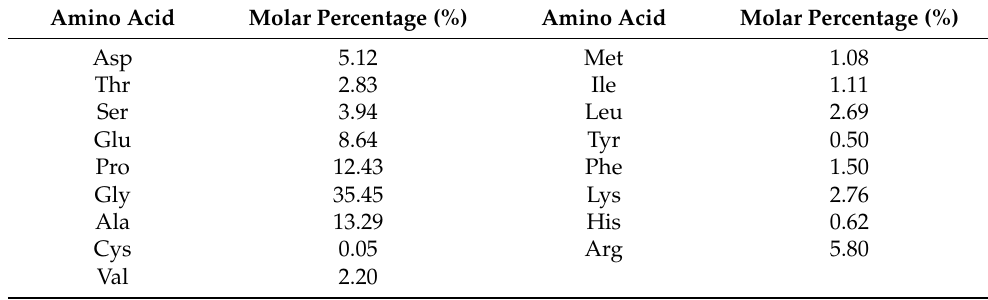
Table 2. Amino acid composition of